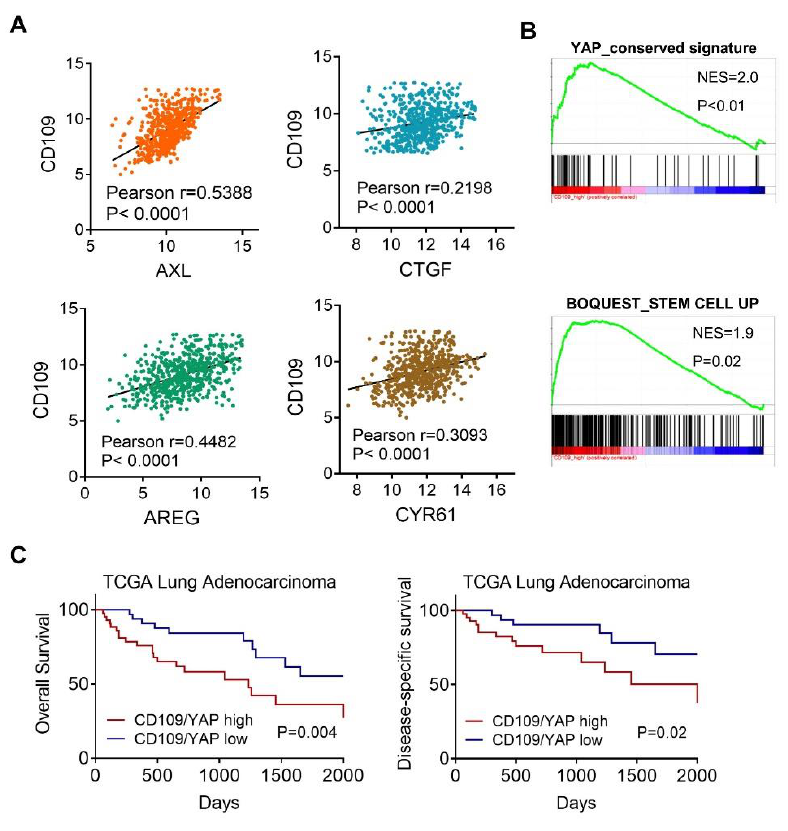
Figure 6. Expression of CD109 is associated with the YAP signature in lung adenocarcinoma patients. ( A ) Associations of CD109 and YAP downstream genes in TCGA lung adenocarcinoma patients (LUAD). Correlations were determined using Pearson’s test. ( B ) GSEA plots of enrichment of YAP and stem cell signatures with CD109 in lung cancer patients. ( C ) Disease-specific survival (DFS) and overall survival (OS) probabilities in lung adenocarcinoma patients stratified by CD109/YAP_high and CD109/YAP_low groups. The survival probability was analyzed by a log-rank (Mantel-Cox) statistical test.